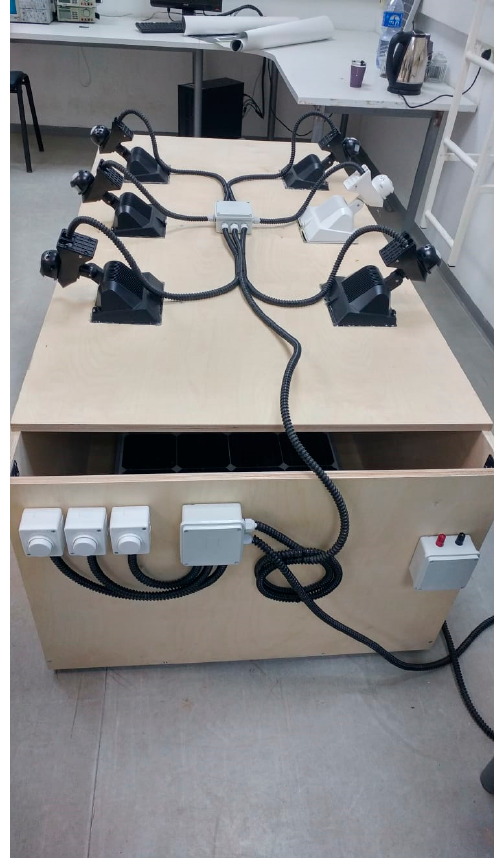
Figure 15. The box with six lamps and three dimmers that was designed for the